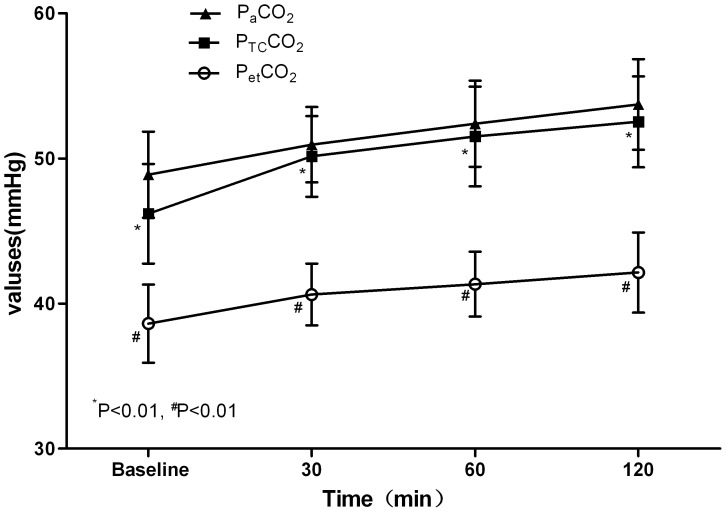
PetCO2, PTCCO2 and PaCO2 at different time points after CO2 pneumoperitoneum.End tidal carbon dioxide partial pressure (PetCO2), transcutaneous carbon dioxide partial pressure (PTCCO2), and arterial carbon dioxide partial pressure (PaCO2) at baseline, 30 minutes after, 60 minutes after, and 120 minutes after CO2 pneumoperitoneum. *P<0.01, compared with PaCO2. #P<0.01, compared with PaCO2.